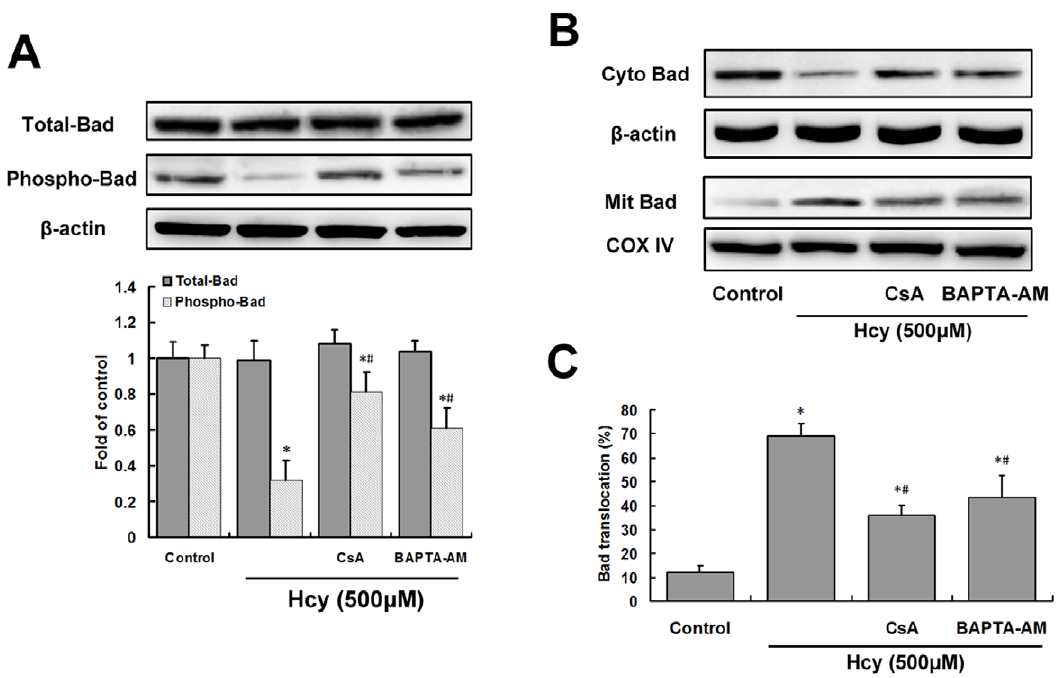
Figure 4. Calcineurin activation contributes to Hcy-induced dephosphorylation and mitochondrial translocation of Bad. Cells were pretreated with 1 m M CsA or 10 m M BAPTA-AM for 30 min before treatment with 500 m M Hcy ( Hcy ) for 24 h. A, Total Bad and phospho-Bad levels were assessed by western blotting and densitometric analysis. B, Western blot analysis of Bad in mitochondrial (Mit) and cytoplasmic (Cyto) fractions from hippocampal neurons. C, Percentage of total Bad (cytoplasmic + mitochondrial fractions) localized to the mitochondrial fraction was determined by densitometric analysis of the data from B. Results are expressed as the mean 6 S.E.M. of three experiments. * P , 0.05 vs. control. # P , 0.05 vs. Hcy treatment